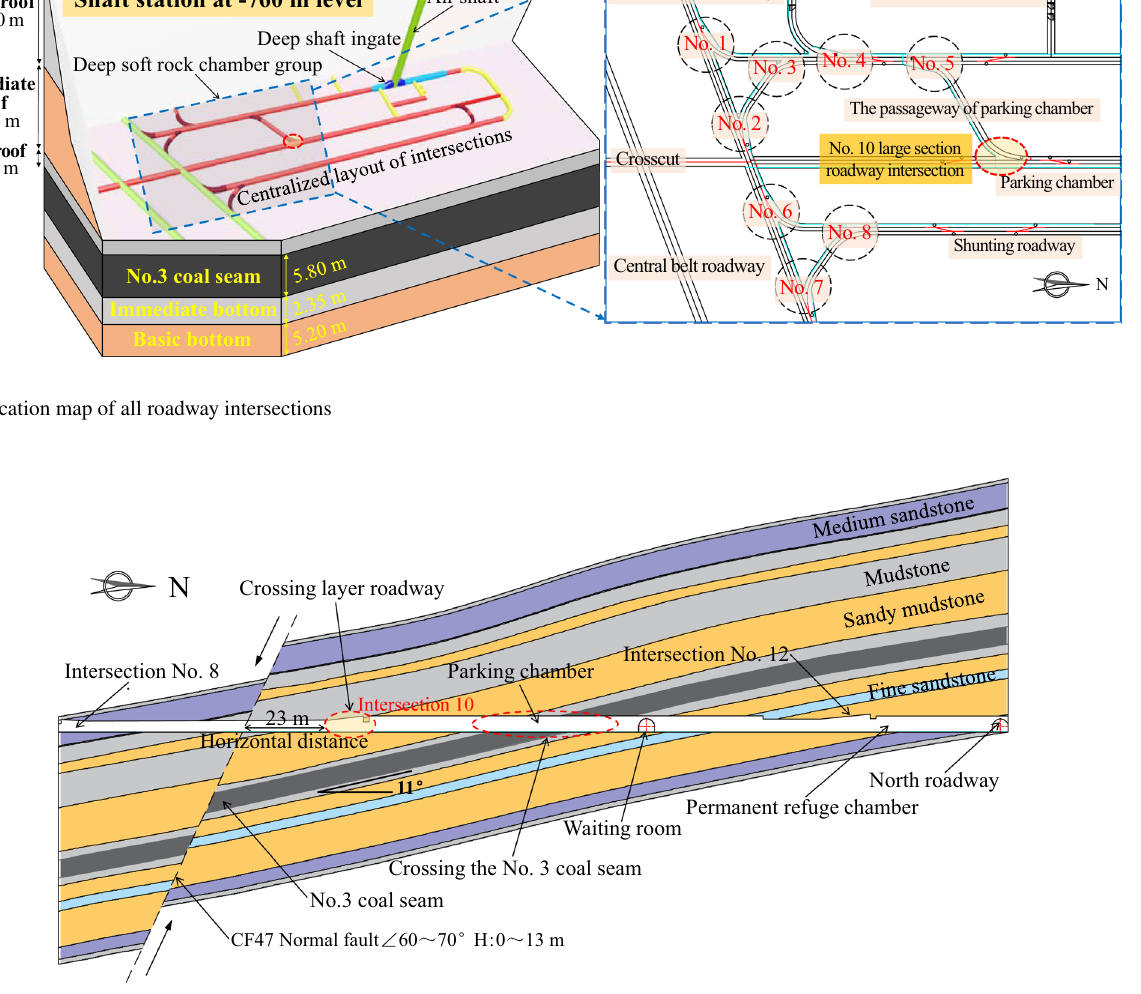
Fig. 3 Stratigraphic profile at the No. 10